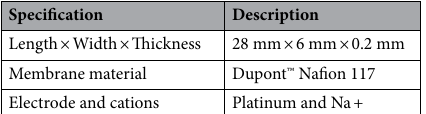
Table 1. Specifications of the IPMC strip used in this research.